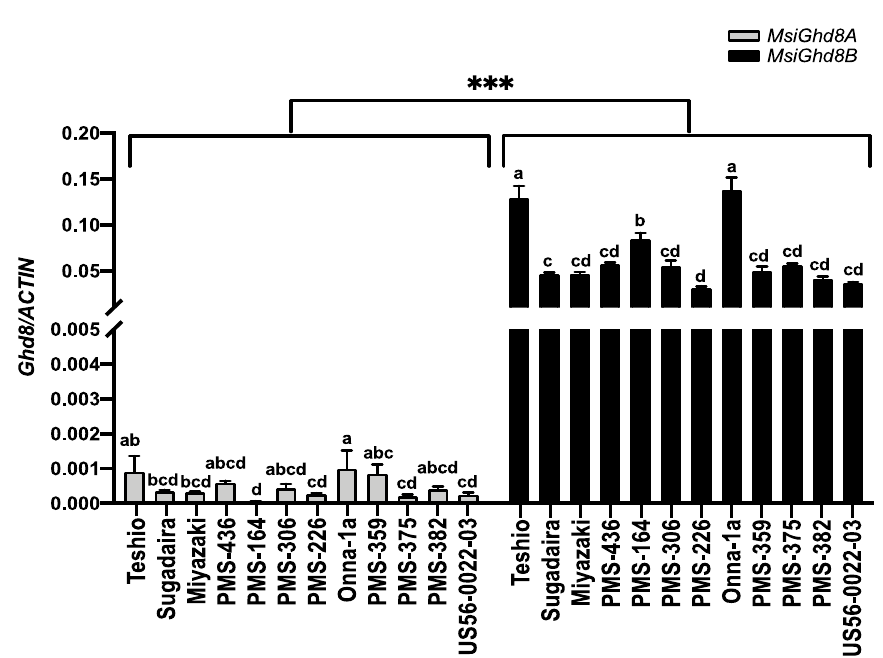
Figure 4. Expression of MsiGhd8 at Zeitgeber time 9 for 12 Miscanthus sinensis accessions under long days (15 h). Grey and black represent MsiGhd8A and MsiGhd8B , respectively. Relative mRNA levels are expressed as the ratios to ACTIN transcript levels. Mean ± 1SE for three replications are given for each data point. A different letter on top of a bar indicates significant difference between accessions within each subgenome according to the Tukey HSD (95% family-wise confidence level) multiple comparison tests. *** shown between the two subgenomes indicates a significant difference at p < 0.001 according to the Student’s t -test.